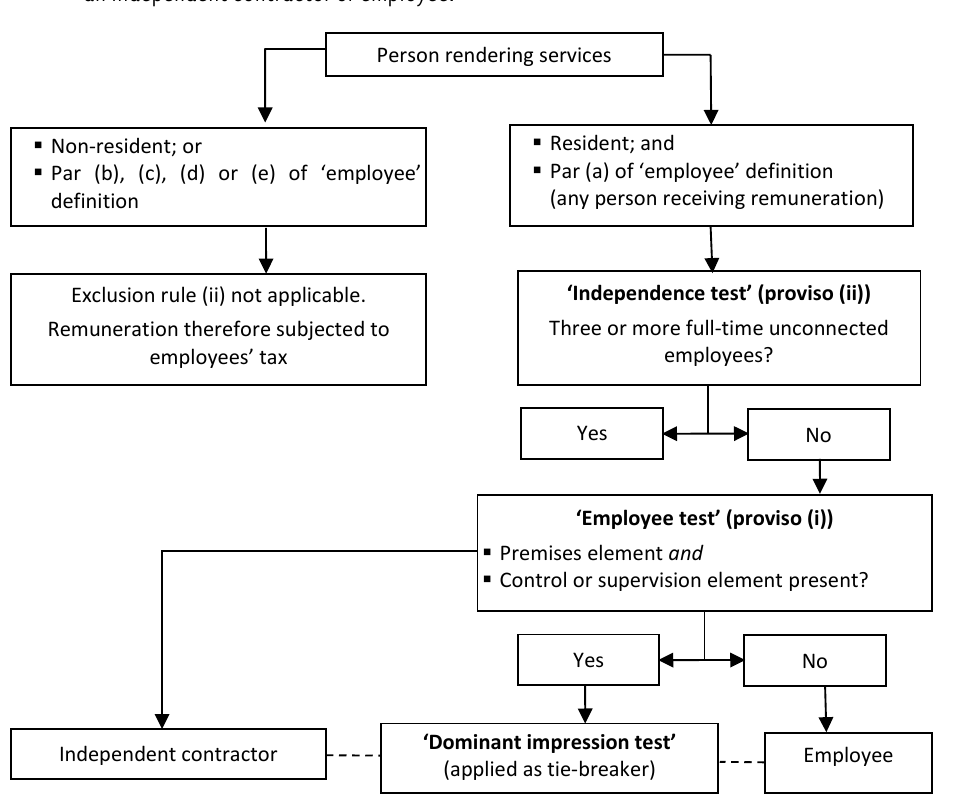
FIGURE 1: Exclusion rule (ii) in definition of ‘remuneration’